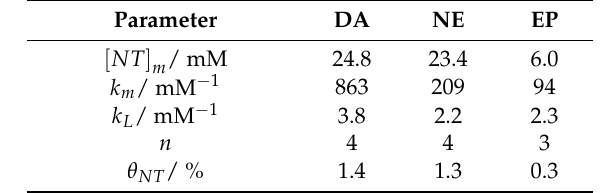
Table 2. Calculated parameters for the adsorption isotherms of neurotransmitters: concentration of neurotransmitter equivalent to an adsorbed monolayer [ NT ] monolayer k m , affinity constant for multilayers k L , maximum number of adsorbed layers n , and surface coverage θ NT